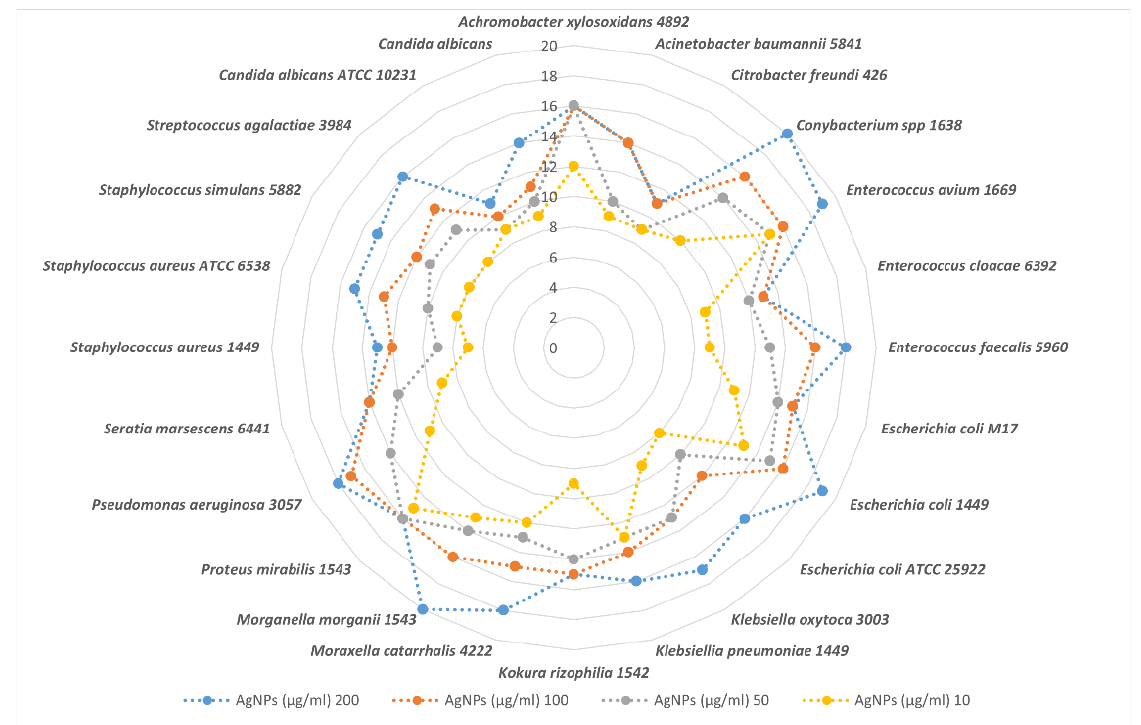
Figure 6. Radar chart obtained from Excel software showing the inhibition diameters of various concentrations of green-synthetized AgNPs using E. Chlorantha bark extract on the tested strains.